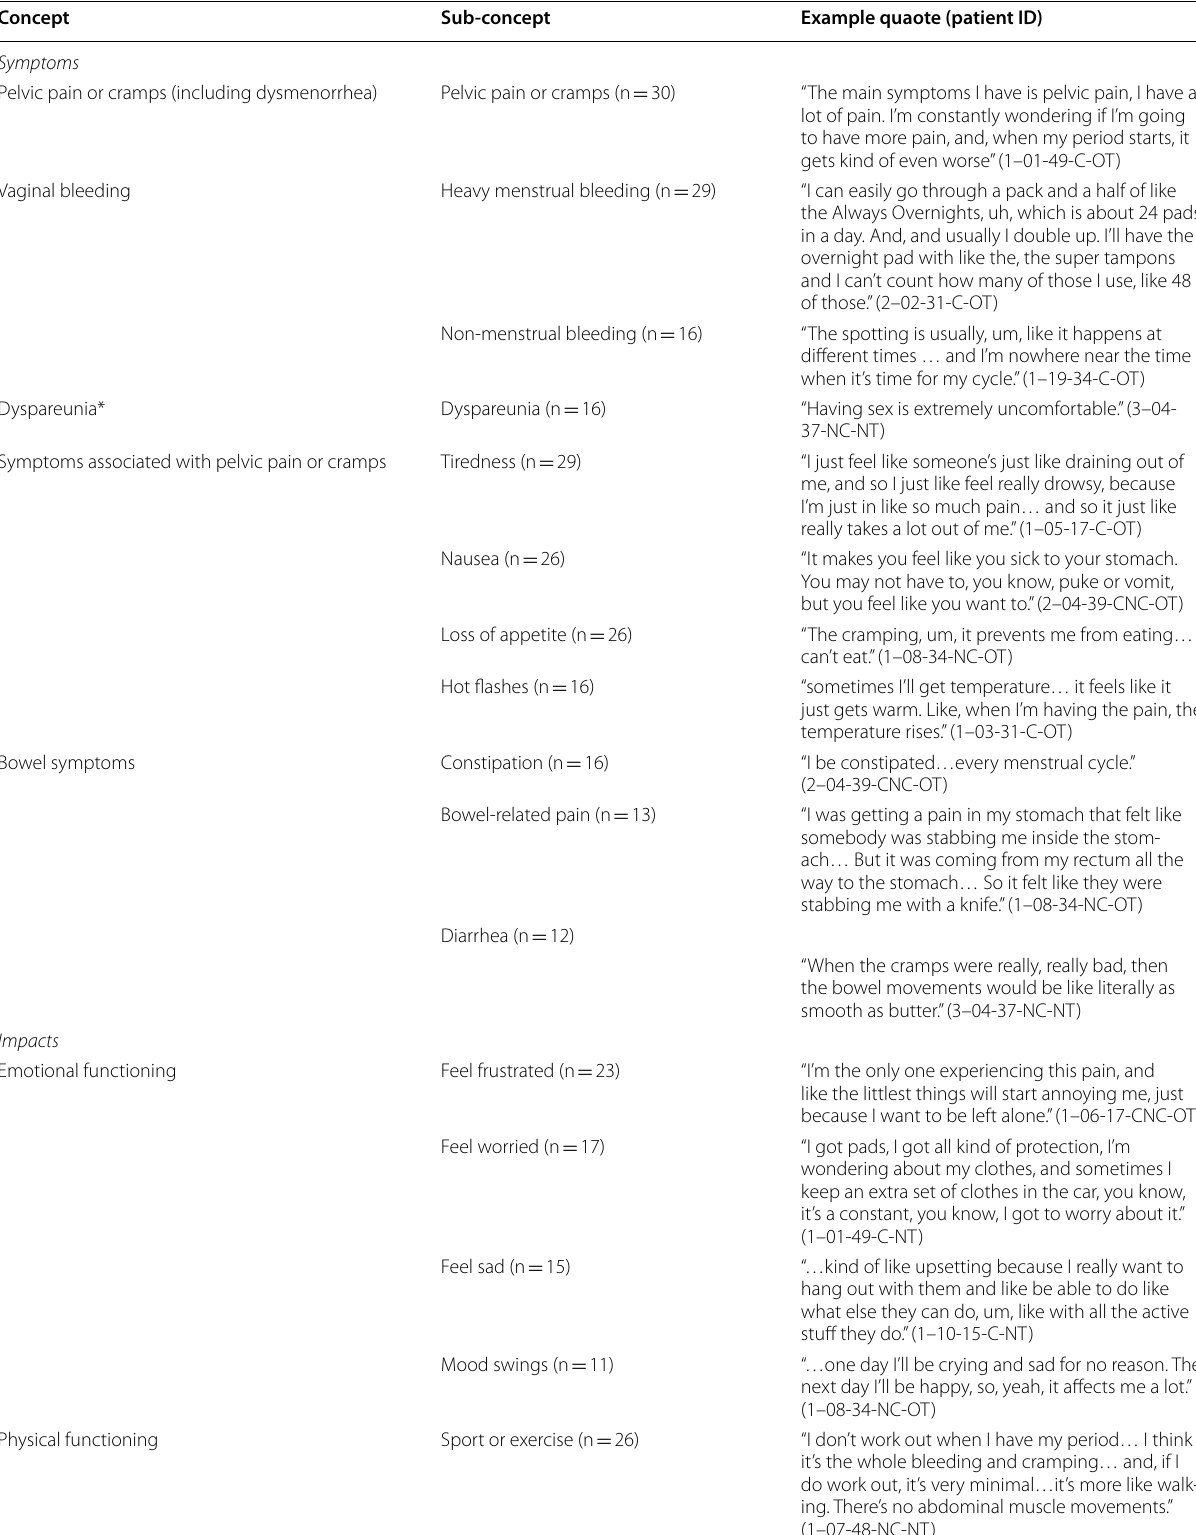
Table 2 Concept elicitation interviews: overview of key symptoms and impacts reported by participants (N